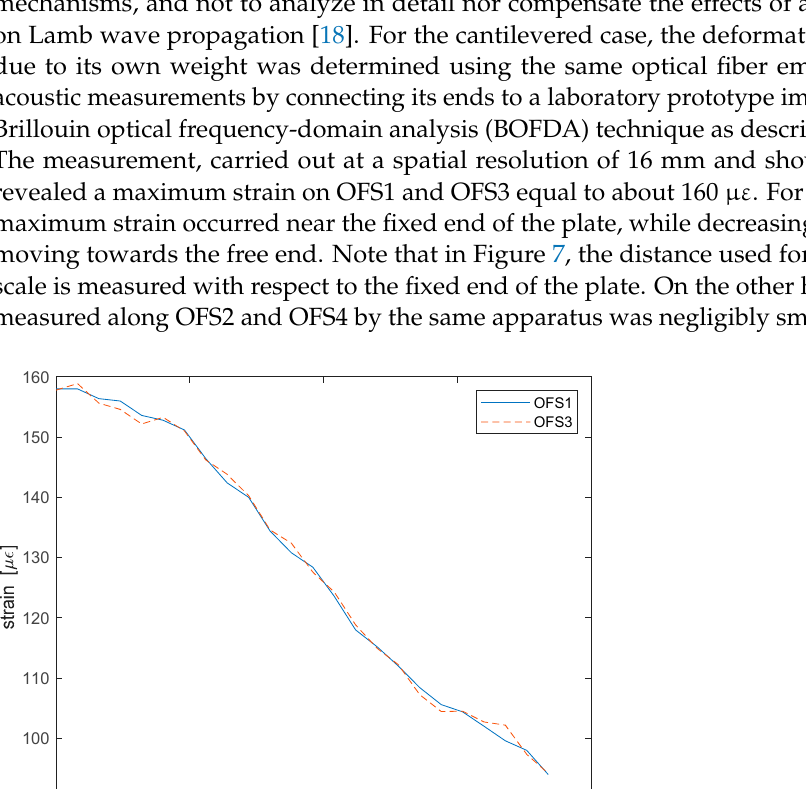
Figure 8. Responses of the PZTs with the plate in rest conditions (blue curves) or cantilever condi- tions (red curves).